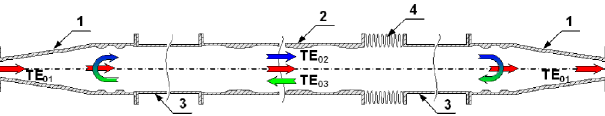
(cid:2) forward (cid:3) - TE (cid:2) backward (cid:3) , the operating 02 03 (cid:2) forward (cid:3) - TE (cid:2) backward (cid:3) , the de- 03 02